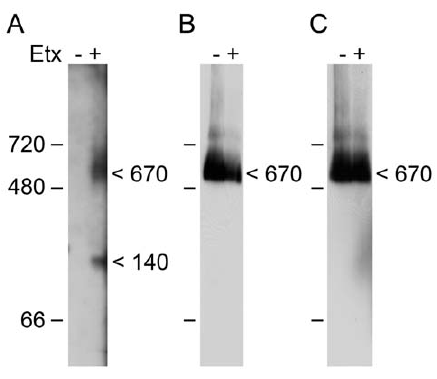
Figure 7. Protein complexes analysed under non-denaturing conditions . ACHN cells were either untreated (control) or treated with GFP-labeled e -toxin. Membrane protein extracts were separated using blue-native PAGE and analyzed by immunoblotting with anti-GFP (A), anti-CAV1 (B), or anti-CAV2 (C). The positions of proteins molecular weight markers and the estimated sizes of proteins complexes are shown.